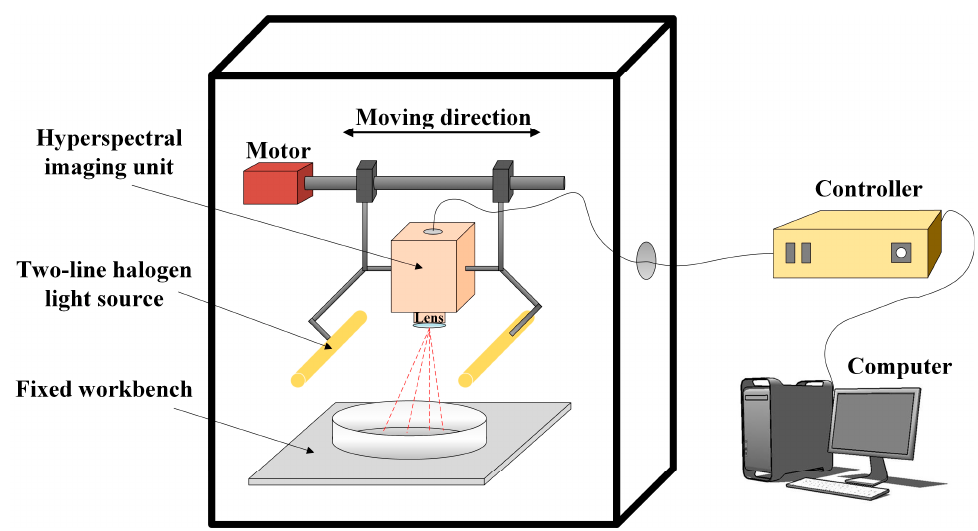
Figure 1. Diagram of the hyperspectral imaging (HSI) system.